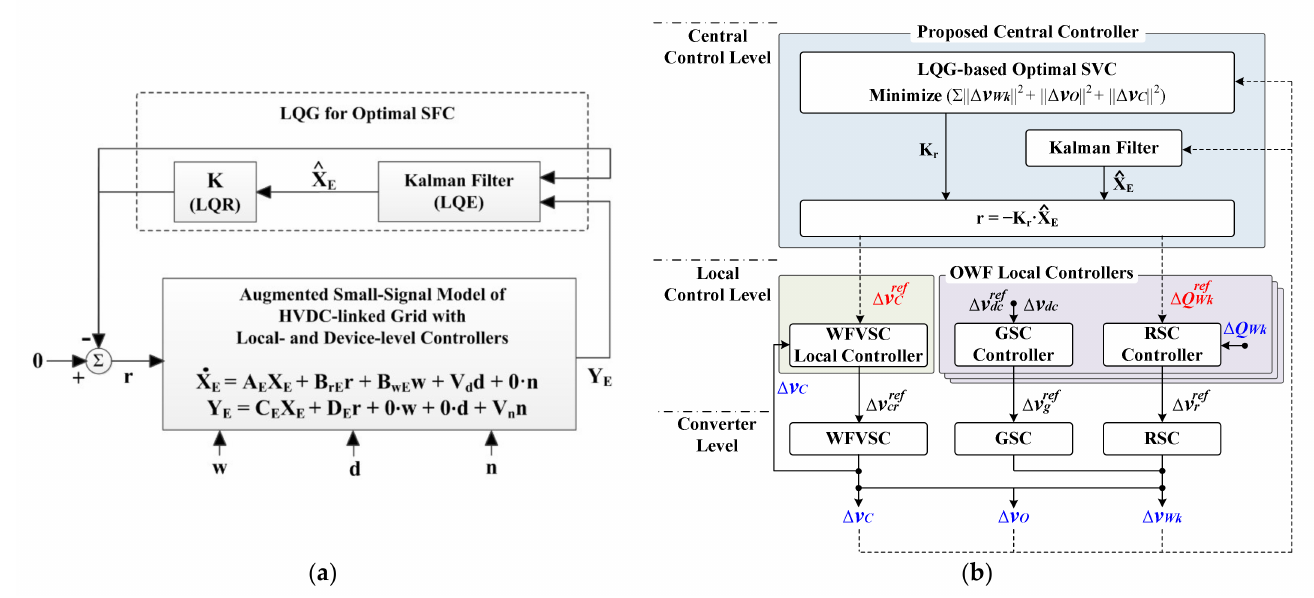
Figure 2. Use of an LQG regulator to generate optimal reference signals for the individual local controllers of the HVDC system and the OWFs: ( a ) frequency control and ( b ) voltage control.